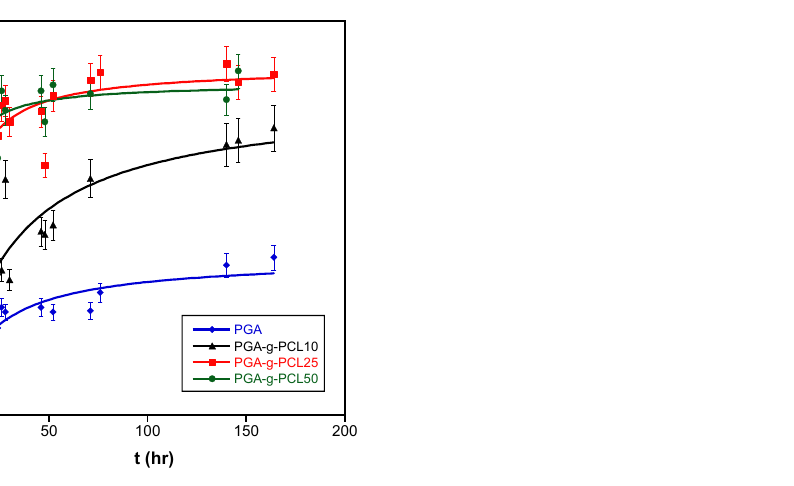
Figure 4. Kinetics of drug release from PGA and PGA ‐ g ‐ PCL nanoparticles in PBS (pH = 7.4) at 25 °C.